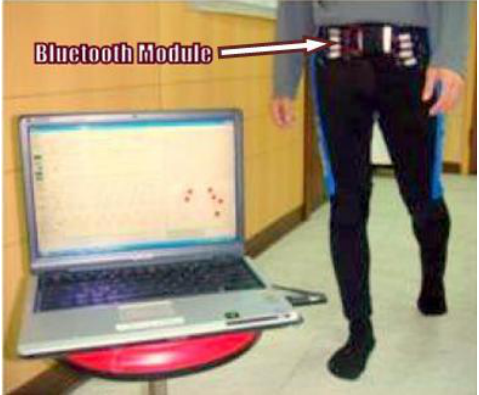
Figure 23. A wireless gait analysis system by digital textile sensors [53].